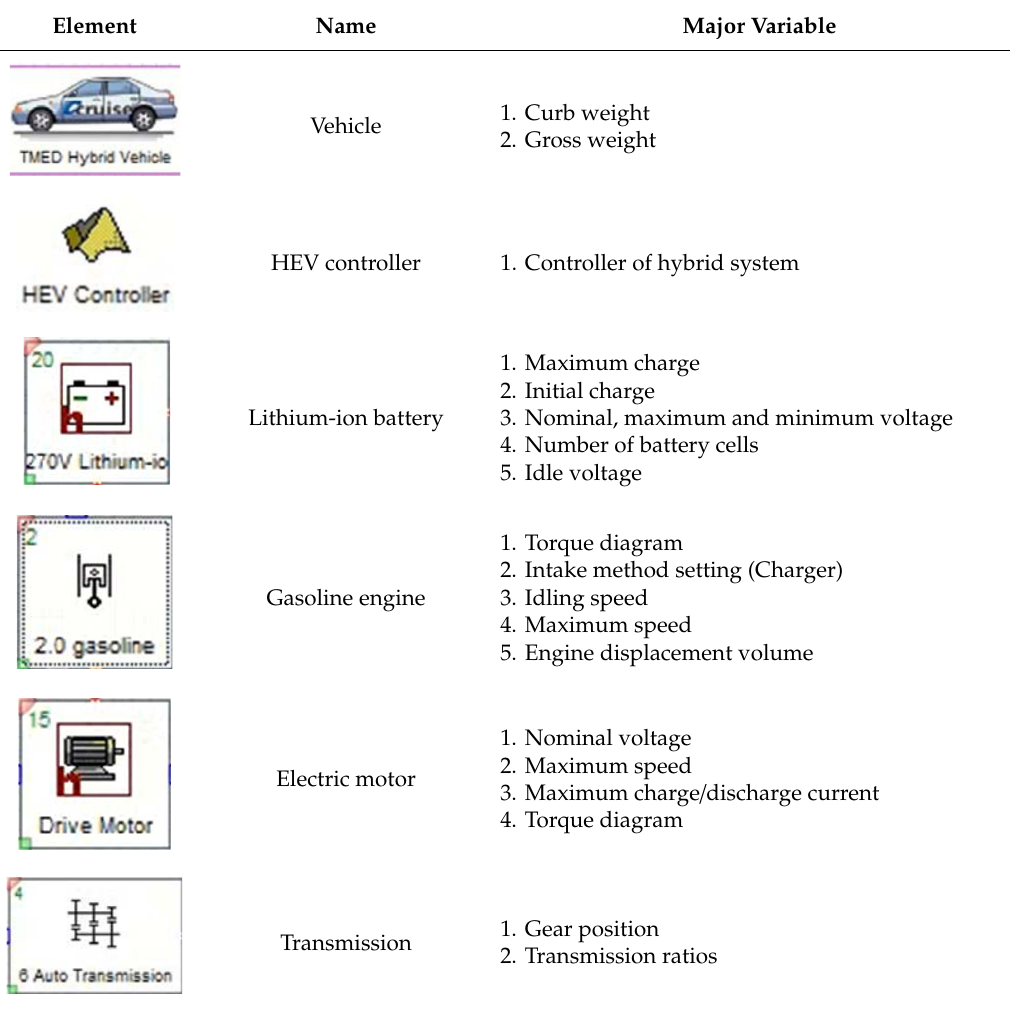
Figure 5. Full numerical model of TMED ‐ type HEV developed using CRUISE. Table 2. Main elements of a hybrid vehicle model under CRUISE.